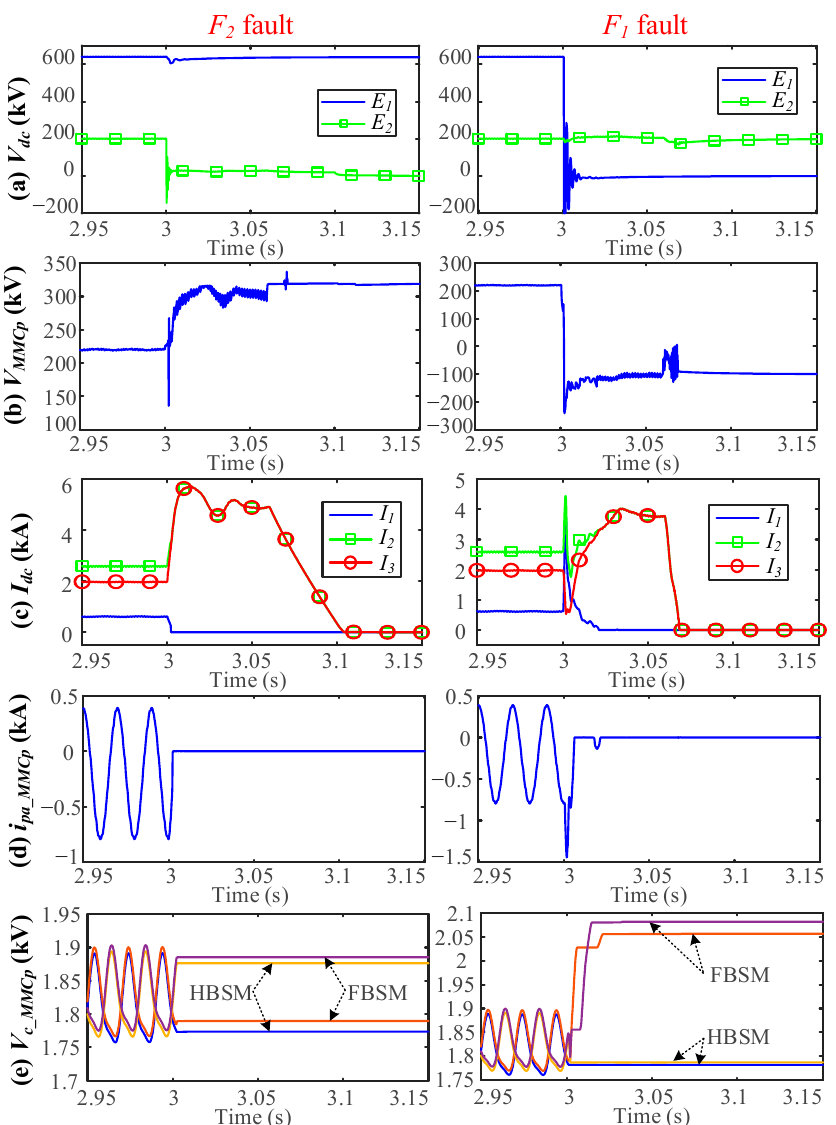
Figure 9. System performance to DC faults: ( a ) system DC voltage; ( b ) converter DC voltage; ( c ) system DC current; ( d ) upper arm current of MMC p phase A; ( e ) average upper/lower arms FBSM and HBSM capacitor voltage of MMC p phase A.